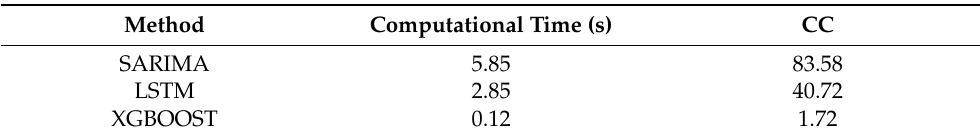
Table 3. Computational complexity for univariate time series.